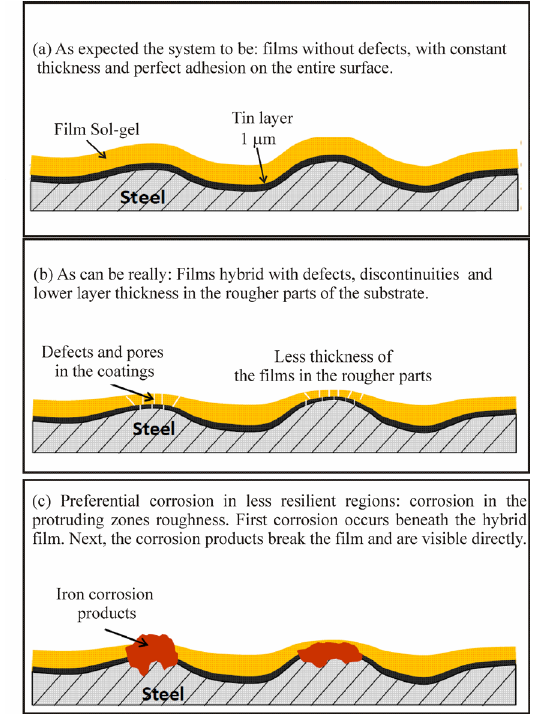
Figure 13. Corrosion mechanism for the tinplate coated with hybrid film in the electrolyte NaCl solution. Figure 12-e shows, in more detail, the corrosion formed on the surface of the TP-HF sample. A detailed analysis of the SEM image of the sample shows that corrosion occurs at specific points (Figures 12-f-g). Moreover, it is noted that the corrosion products appear mainly in the hybrid film irregularities, which are shaped irregularities